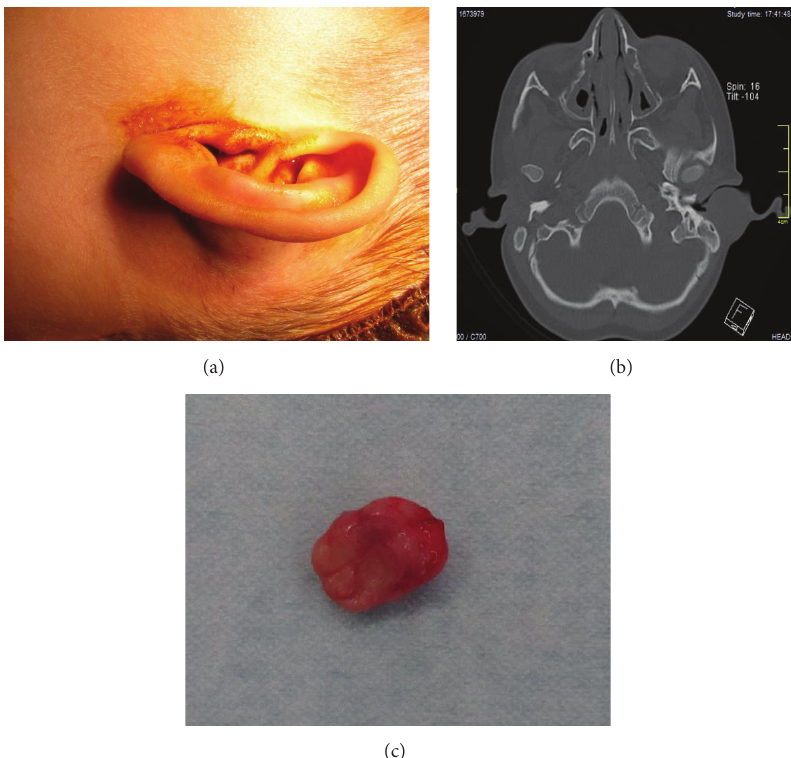
Figure 1: (a) Smooth, rubbery mass in the left postauricular area, displacing the conchal cartilage anteriorly and obstructing the EEC. (b) Axial CT image showing a homogenous, hypodense, solid soft tissue mass in the postauricular area. (c) Fresh, unfixed specimen after surgical